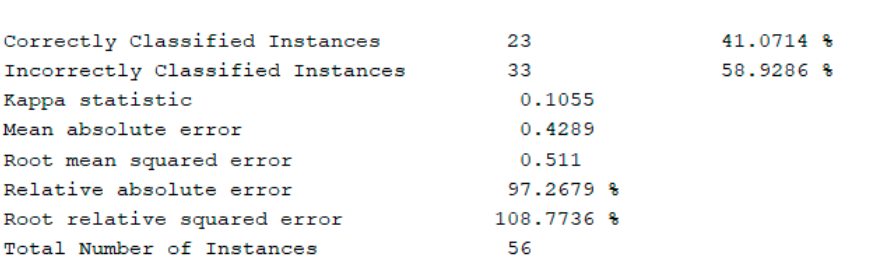
Figure 4. Summary of the values obtained in the instances of correct and incorrect classification and the details of values by class.